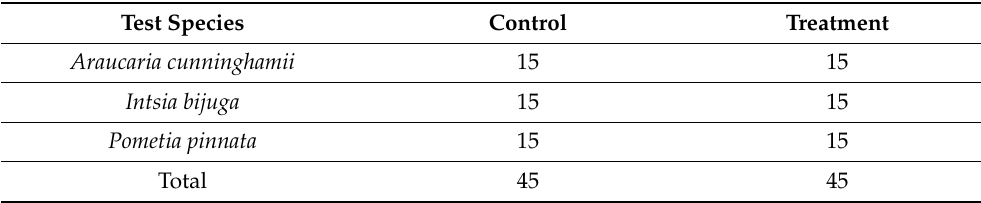
Table 2. Control and treatment specimens and their replicates per test species.